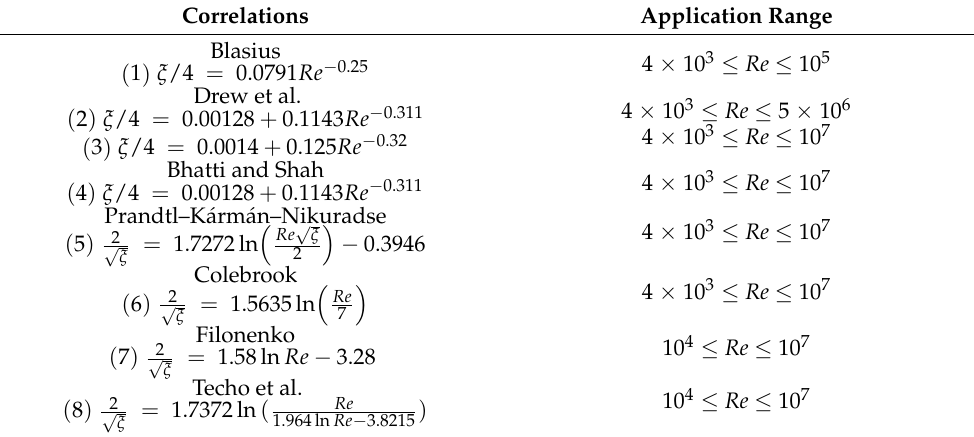
Table 3. Correlations for friction factor, [23]. Correlations